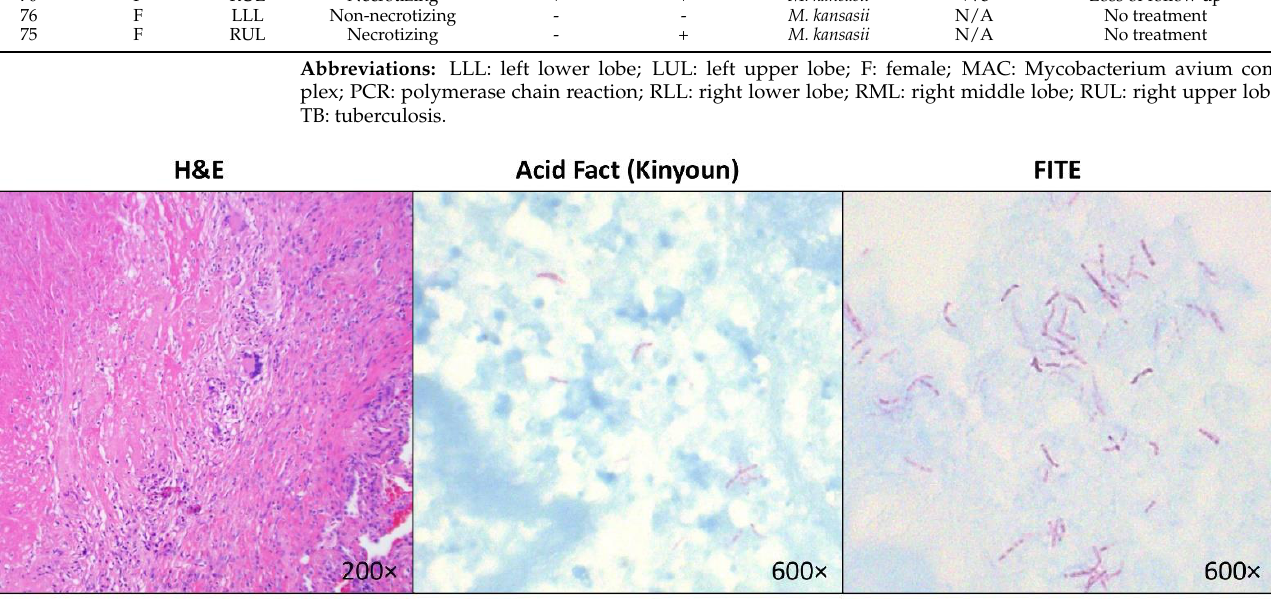
Figure 1. Representative images of a lung tissue section with necrotizing granuloma stained with Hematoxylin & Eosin (left panel) and mycobacteria identified on Kinyoun acid-fast stain (middle panel) and FITE stain (right panel) in a patient who grew Mycobacterium kansasii , which was confirmed by PCR.